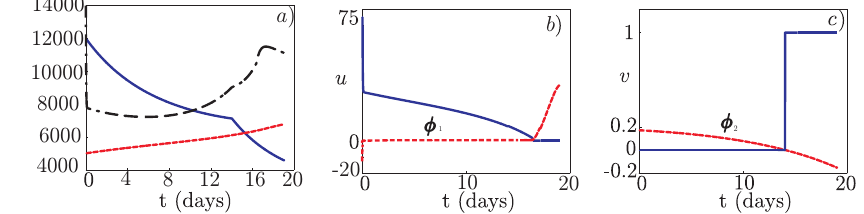
Fig. 12 [Color Online]. a) Evolution of the solutions to Eqs. (52), (53) and (54), p (solid line), s (dotted line), and q (solid-dot line) with the initial conditions ( p 0 , s 0 , q 0 ) = ( 12000 , 5000 , 14000 ) b) Optimal control u ( t ) (solid line) and switching function φ 1 (dotted line) for M = 300 doses and u M = 75 c) Optimal control v ( t ) (solid line) and switching function φ 2 (dotted line) for N = 5 doses and v M = 1.